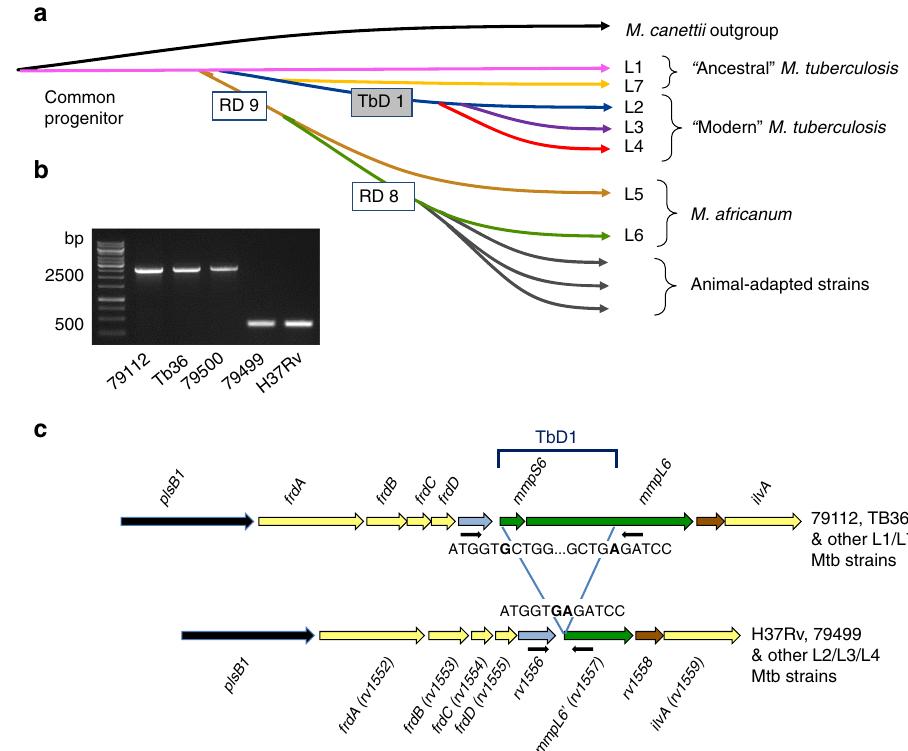
Fig. 1 The TbD1 locus in ancestral and modern Mtb strains. a Evolutionary scheme of the Mycobacterium tuberculosis complex following reference 2 , showing some key large sequence polymorphisms, including the deletion of the TbD1 region, which indicates the common evolutionary origin of the lineage L2, L3 and L4 strains. b Ampli fi cation pro fi les on genomic DNAs from the different “ Indian ” strains, demonstrating the presence of a 2459-bp fragment (corresponding to an intact TbD1 locus) in 79112, Tb36 and 79500 strains and a 349-bp fragment resulting from the TbD1-deletion, in 79499 and H37Rv strains. Primers speci fi c for the TbD1- fl anking regions used in PCR reactions are depicted as black arrows in panel c. c Schematic representation of gene organization at the TbD1 locus and fl anking genes in ancestral and modern Mtb strains. The sequence of the junction regions of the TbD1 locus in 79112 and H37Rv strains, as determined by genome sequencing, is also